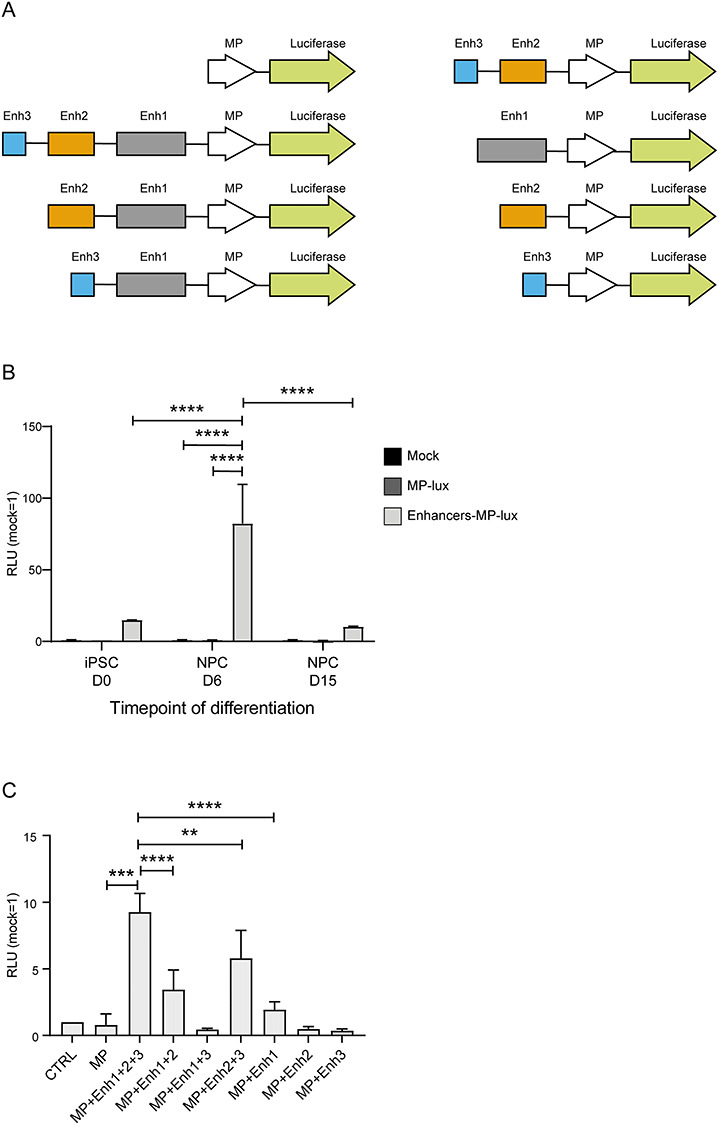
The three novel identified enhancers co-operate to drive upregulated activity of the minimal ZEB2 promoter in a cell state/time specific manner. (A) schematic overview of combinatorial luciferase reporter-based constructs used in this study. (B) Luciferase assay performed in differentiating iPSCs transfected with a luciferase-based construct containing the three identified enhancers together with the minimal promoter of ZEB2 shows differential luciferase activation according the cell state A basal level of activation can be observed already at undifferentiated, D0, state. Similar level is also detected at mature NPC state, D15, while the highest expression is at D6, neural rosette/early NPC state. (C) Luciferase reporter assay of the whole panel of constructs, transiently transfected to heterologous HEK293T cells (see also the Discussion section). As for NPCs, the three enhancers positively co-operate. MP, minimal promoter of ZEB2. Error bars represent standard deviation of three independent biological replicates. Statistical significance was calculated with GraphPad Prism using a multiple comparison one-way Anova test. Asterisks represent P-values: *P < 0.05; **P < 0.005; ***P < 0.0005; ****P < 0.0001.